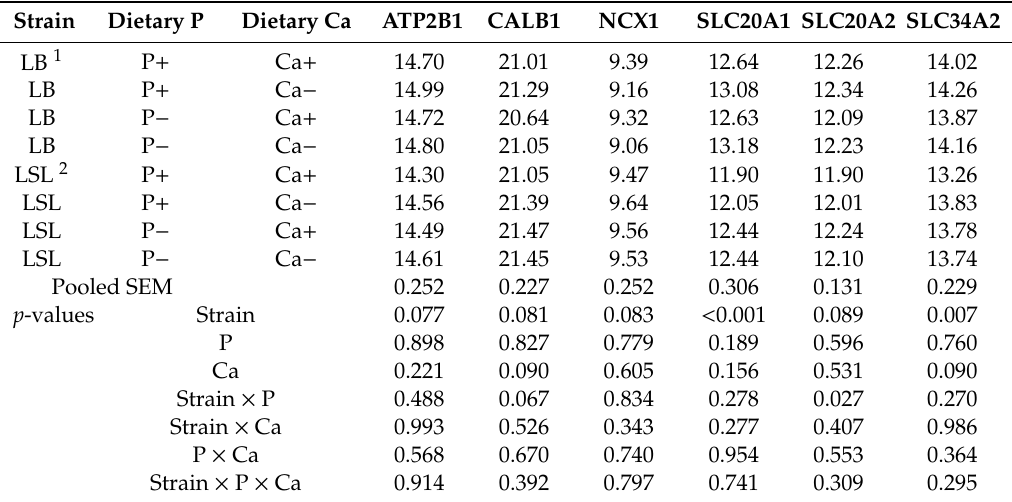
Table 8. E ff ect of strain, P, and Ca on transcript copy numbers of Ca and P transporters in the ileum of laying hens aged 31 weeks. Copy numbers are displayed as log2